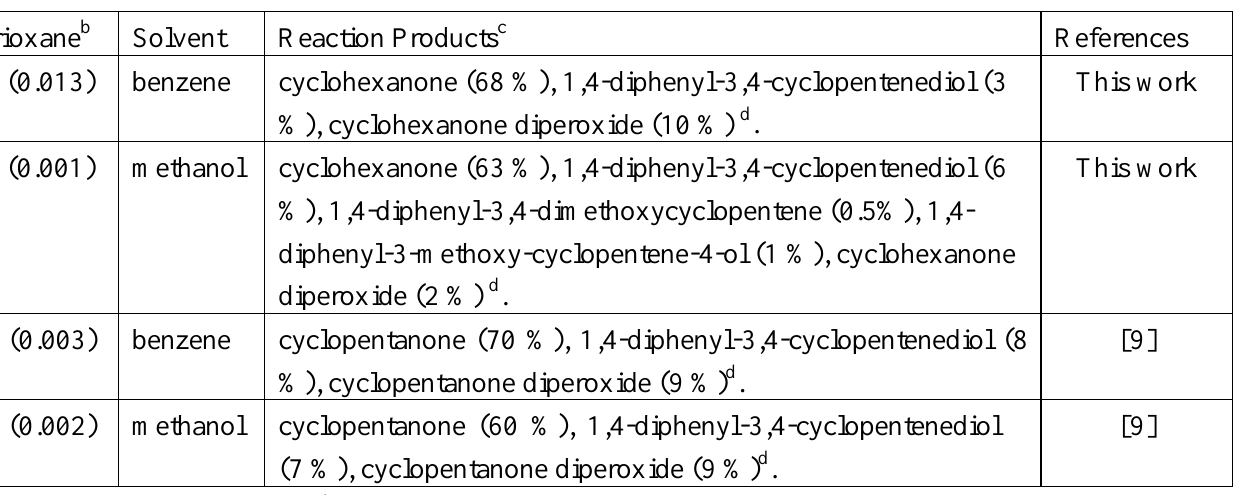
Table III. Products Arising from the Thermolyses a of Ia and Ib in Different